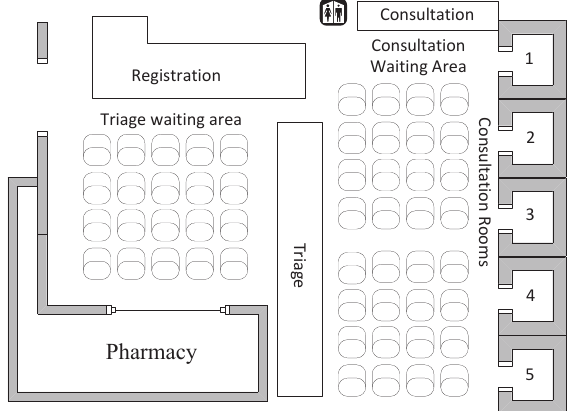
Figure 2. Floor map of waiting area in National University Hospital (NUH) Emergency